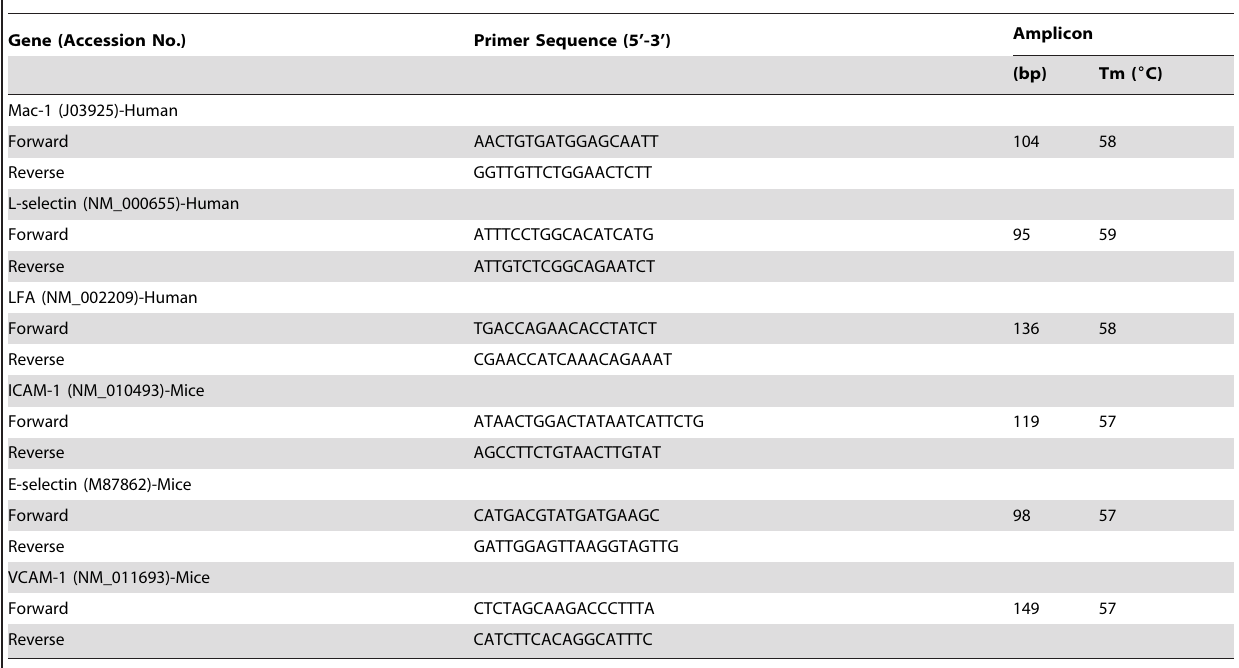
Table 1. Primer sequences used for qRT-PCR.